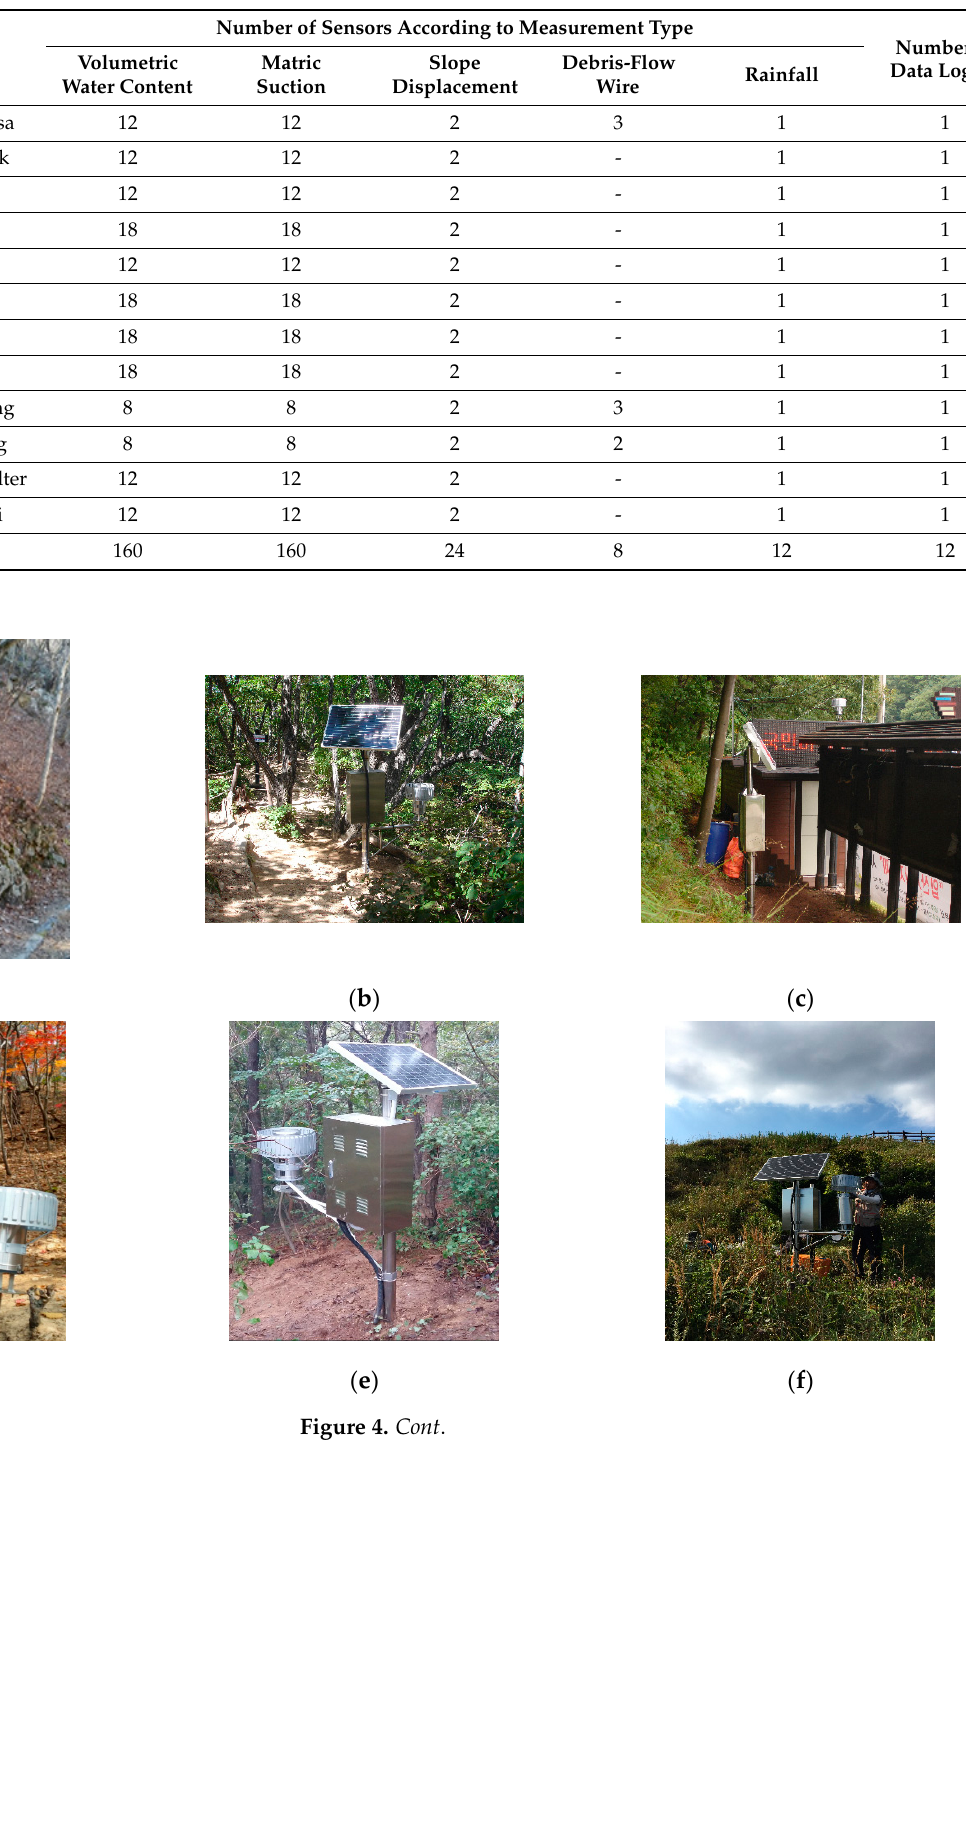
Table 4. Sensors installed in the landslide monitoring stations.